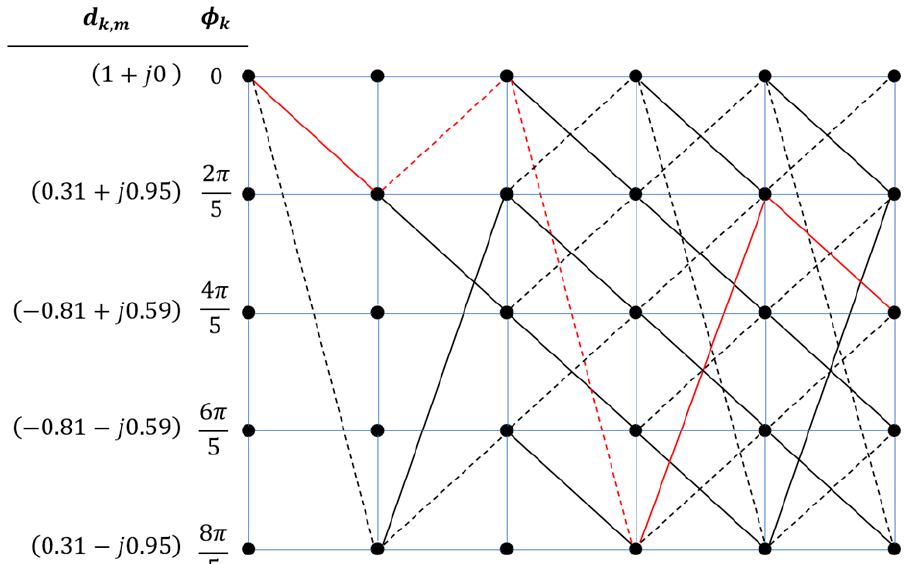
Figure 4. The Viterbi decoder for a typical example with h = 2/5. Bit 1 is indicated by solid lines while bit 0 is indicated by broken lines. The bit sequence 10011 is shown using red colored lines. The outputs of the CPM mapper are shown using the complex numbers under d k , m